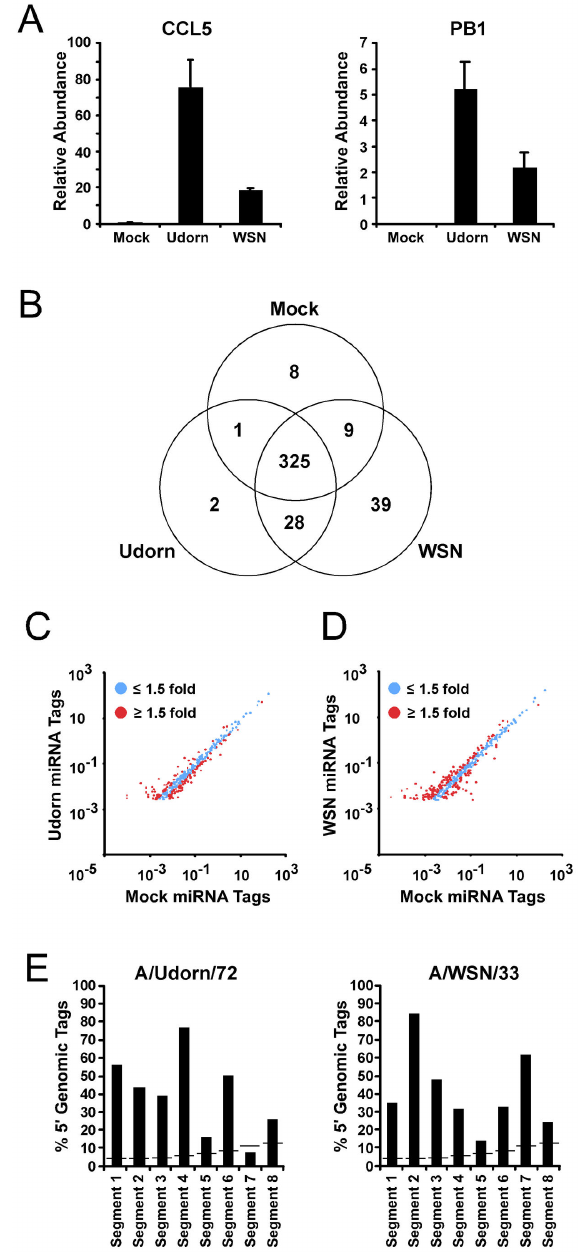
Figure 1. MicroRNA regulation by influenza virus infection. A549 cells were mock infected or infected with either A/Udorn/72 or A/WSN/33 (5 pfu/cell). RNA was purified and size fractionated 10 hours post infection. The low molecular weight RNA was used construct a library for small RNA deep sequencing. (A) High molecular weight RNA was used to measure the expression of the antiviral chemokine CCL5 and the influenza A virus PB1 mRNA by RT-qPCR. (B) Venn diagram indicates the number of common and unique miRNAs identified by a minimum of 100 sequence tags in the indicated sequencing libraries. (C) Comparison of the normalized miRNA sequence tags of the A/Udorn/72 library to the Mock-infected cell library. Blue dots represents miRNAs that exhibit less than 1.5 fold change between libraries. Red dots indicate miRNAs that exhibit greater than 1.5 fold change between libraries. (D) As in (C), comparing the normalized miRNA sequence tags between the A/WSN/33 library and Mock-infected cell library. (E) Histogram indicates the percent of small virally-encoded RNAs that map within 100 nucleotides of the 5’ end of indicated virus genomic RNA segment. The horizontal lines represent the expected percentage of 5’ sequence tags by chance. doi: 10.1371/journal.pone.0076560.g001 PLOS ONE |